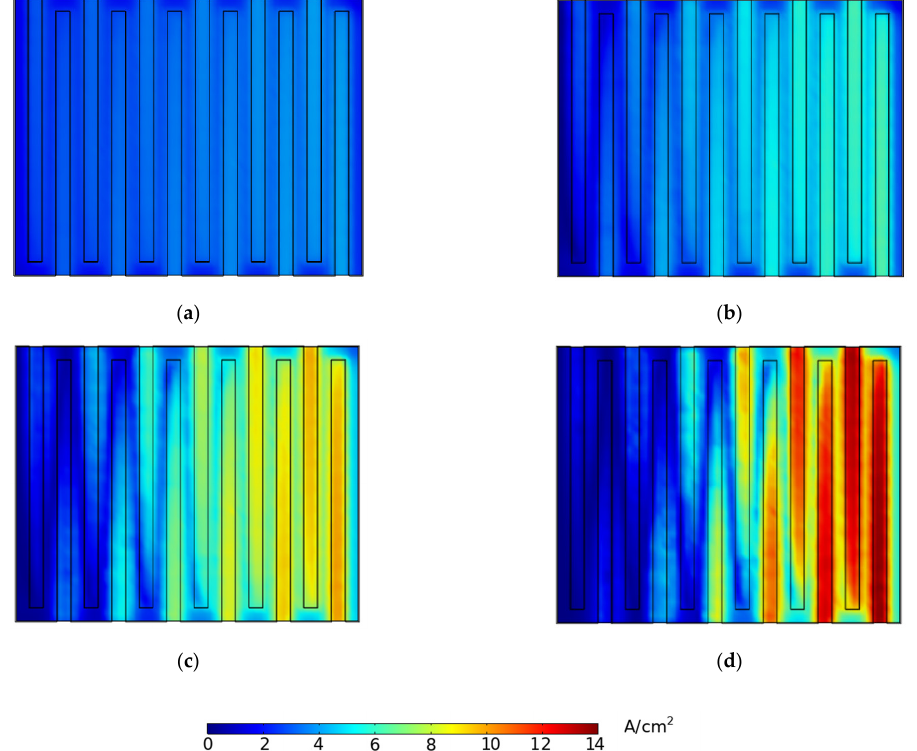
Figure 9. Current density distribution on the anode CL for cell voltages of ( a ) 0.5 V, ( b ) 0.4 V, ( c ) 0.3 V, and ( d ) 0.2 V.